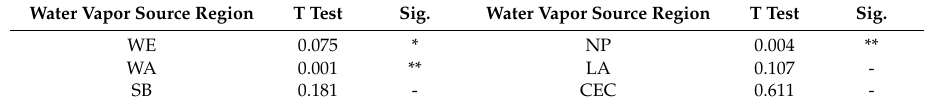
Figure 11. Total q (g / kg) distribution of 6 water vapor source regions: ( a ) WE and WA, ( b ) SB, NP, LA, and CEC. Table 4. Statistics on confidence test for trends in di ff erent water vapor source